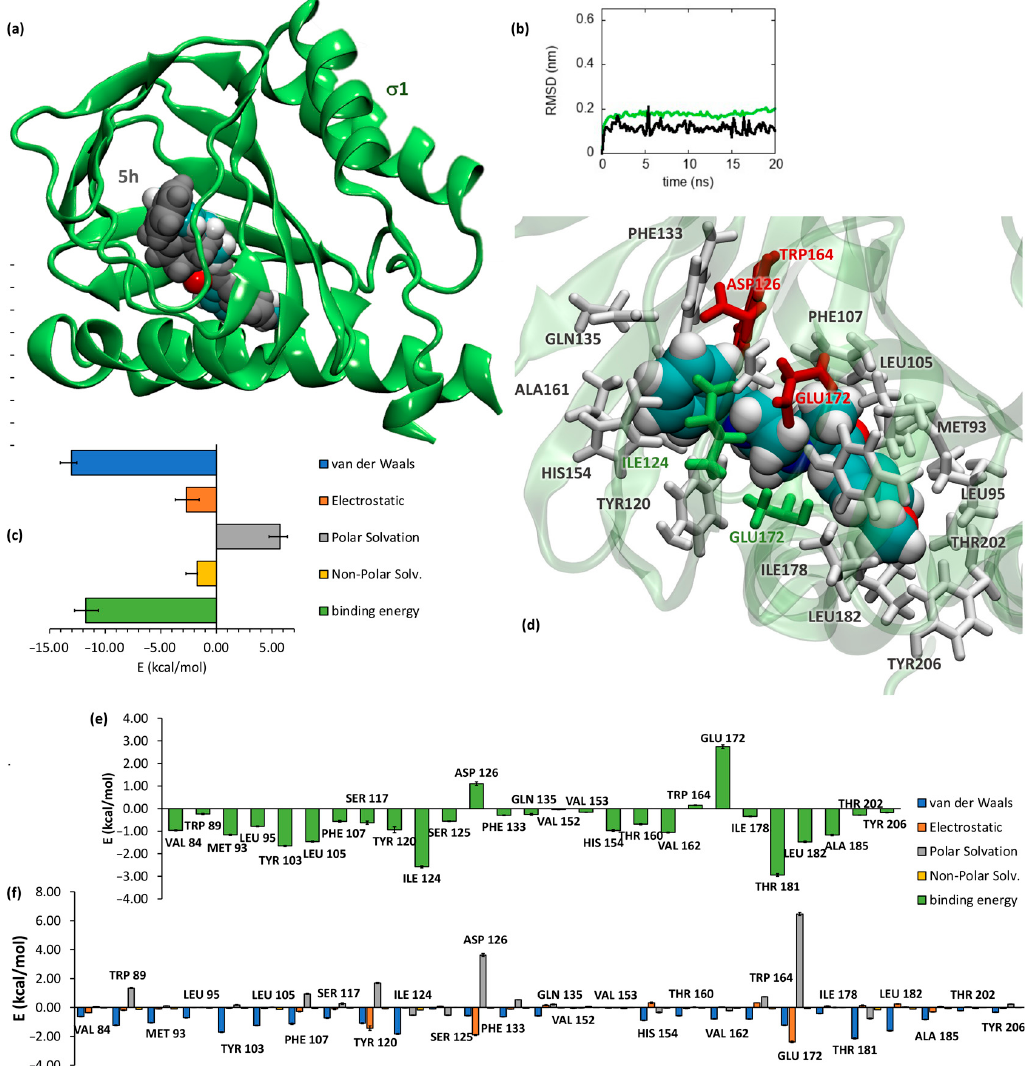
Figure 3. Computational results for compound 5h : ( a ) comparison between docking result and end- simulation conformation, color code: S1 (green), 5h docked conformation (cyan), 5h conformation after 20 ns of molecular dynamics (MD) simulation (gray); ( b ) root mean squared deviation (RMSD) along 20 ns MD for S1 (green) and 5h (black); ( c ) MMGBSA calculated free energy of binding (green) and its components: Van der Waals (blue), electrostatic (orange) polar solvation (gray), and non- polar solvation (yellow), error-bars are standard deviations; ( d ) closest residues contribution to the binding free energy, error-bars are standard errors; ( e ) 5h representative conformation (at t = 4 ns) where S1 is shaded in green and the closest residues to 5h are highlighted and color coded as follows: contributing more than 3 kcal/mol to the binding energy (green), less than 3 kcal/mol (white), and opposing the binding (dark red); ( f ) energy decomposition for each residue: Van der